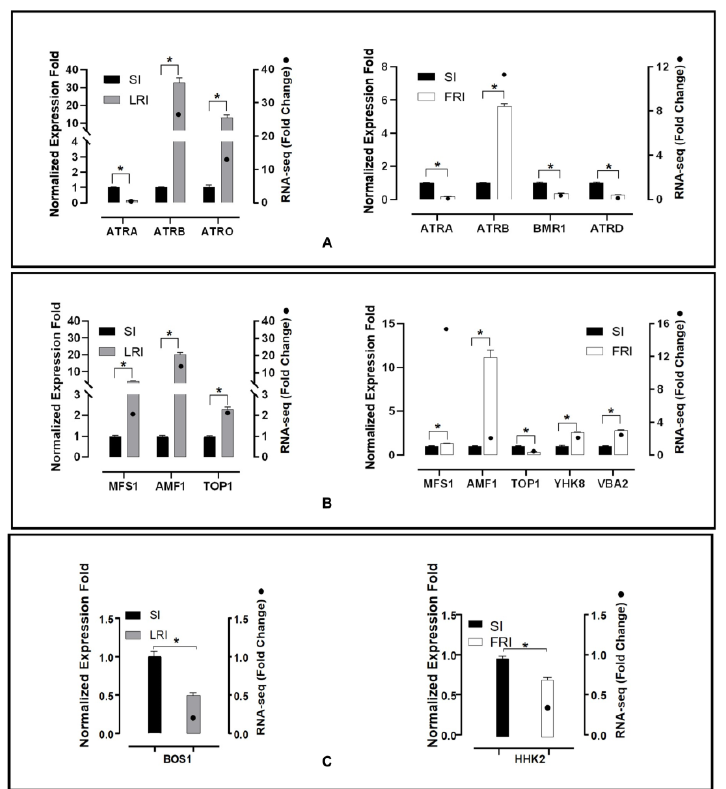
Figure 6. qRT-PCR validation of twelve fludioxonil-responsive DEGs including the ABC transporter genes ( A ), MFS transporter genes ( B ), and catalytic activity encoding genes ( C ). The housekeeping gene, β -actin, was used as an internal reference to calculate the relative mRNA abundance for the